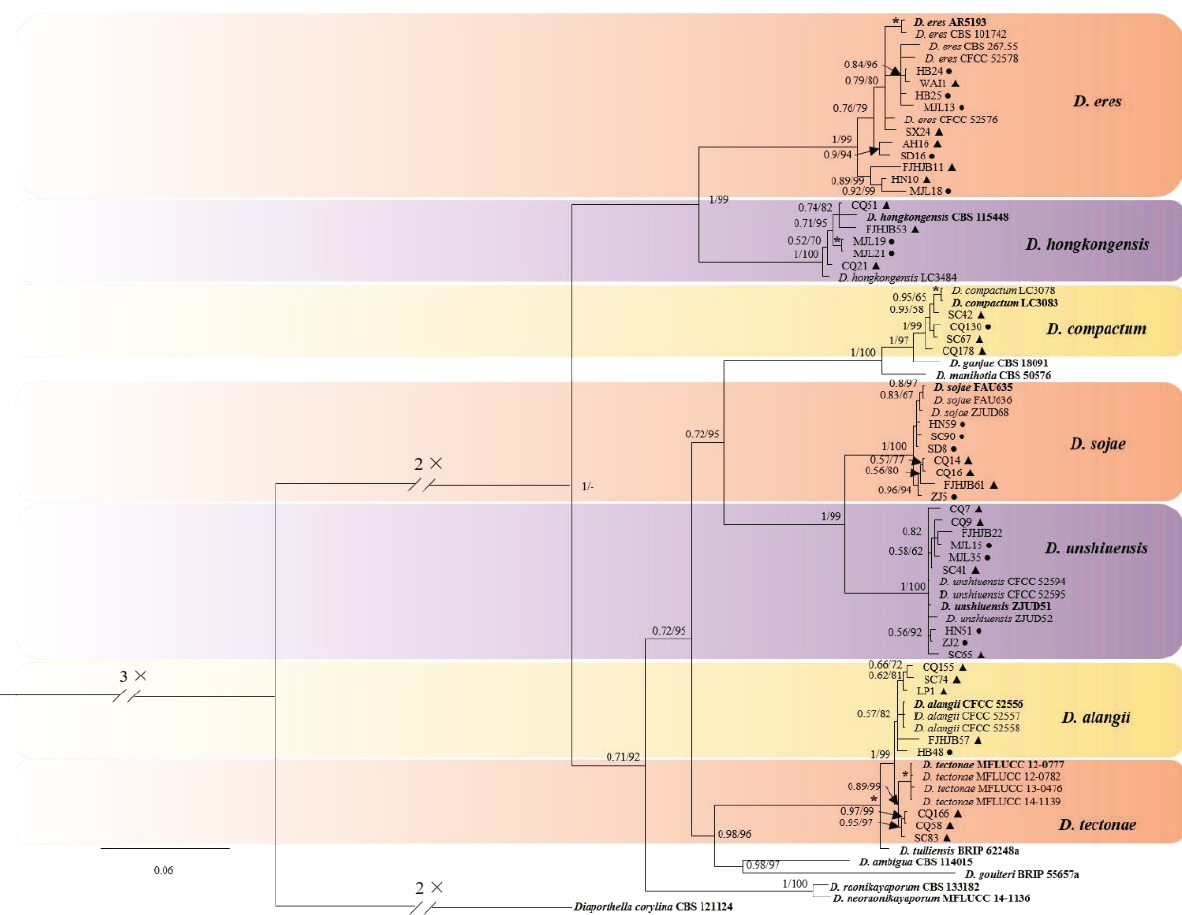
Figure 2. Maximum-likelihood phylogenetic analysis obtained from the combined ITS, EF1-α and TUB2 sequence alignments of 43 Dia- porthe isolates. The species Diaporthella corylina (CBS 121124) was used as the outgroup. Bayesian posterior probability (PP ≥ 0.90), and bootstrap support values > 50% are shown at the nodes. (ML ≥ 50%) were shown at the nodes (PP/ML). Asterisks (*) indicates full support (1/100). Ex-type strains were indicated in bold font. The scale bar indicates 0.06 expected changes per site. Isolate numbers accompanied by circle symbols indicate strains isolated from leaves, and triangle symbols indicate strains isolated from